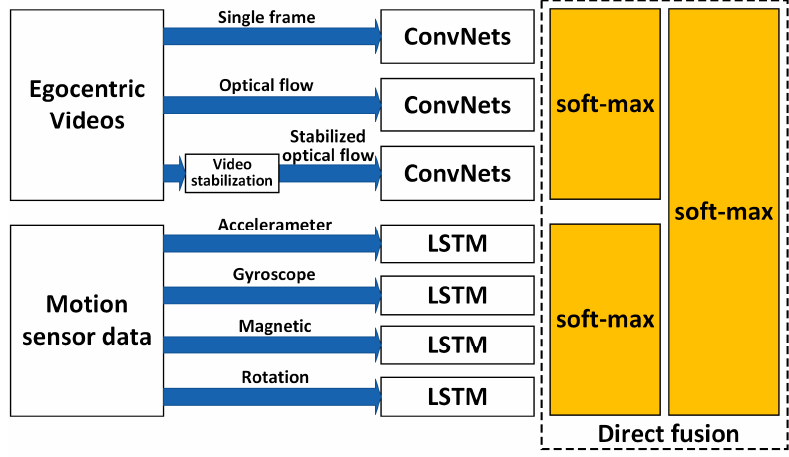
Figure 11. Architecture of the multistream direct fusion method proposed in [14].